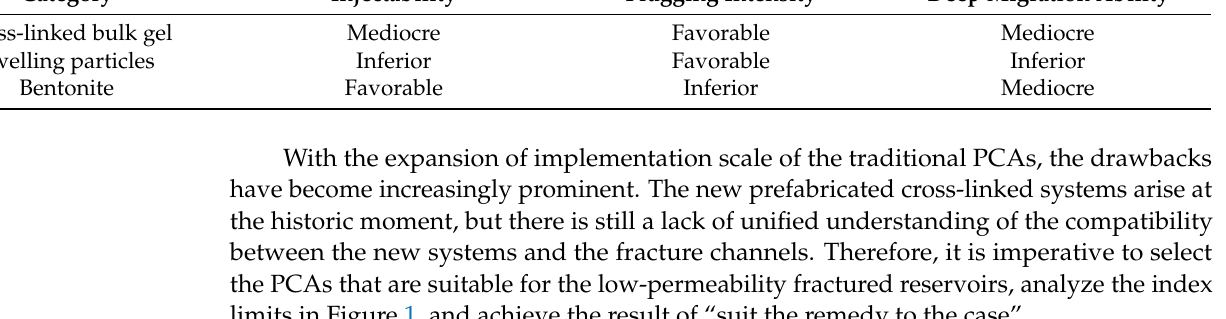
Table 4. Performance differences of different types of PCAs.